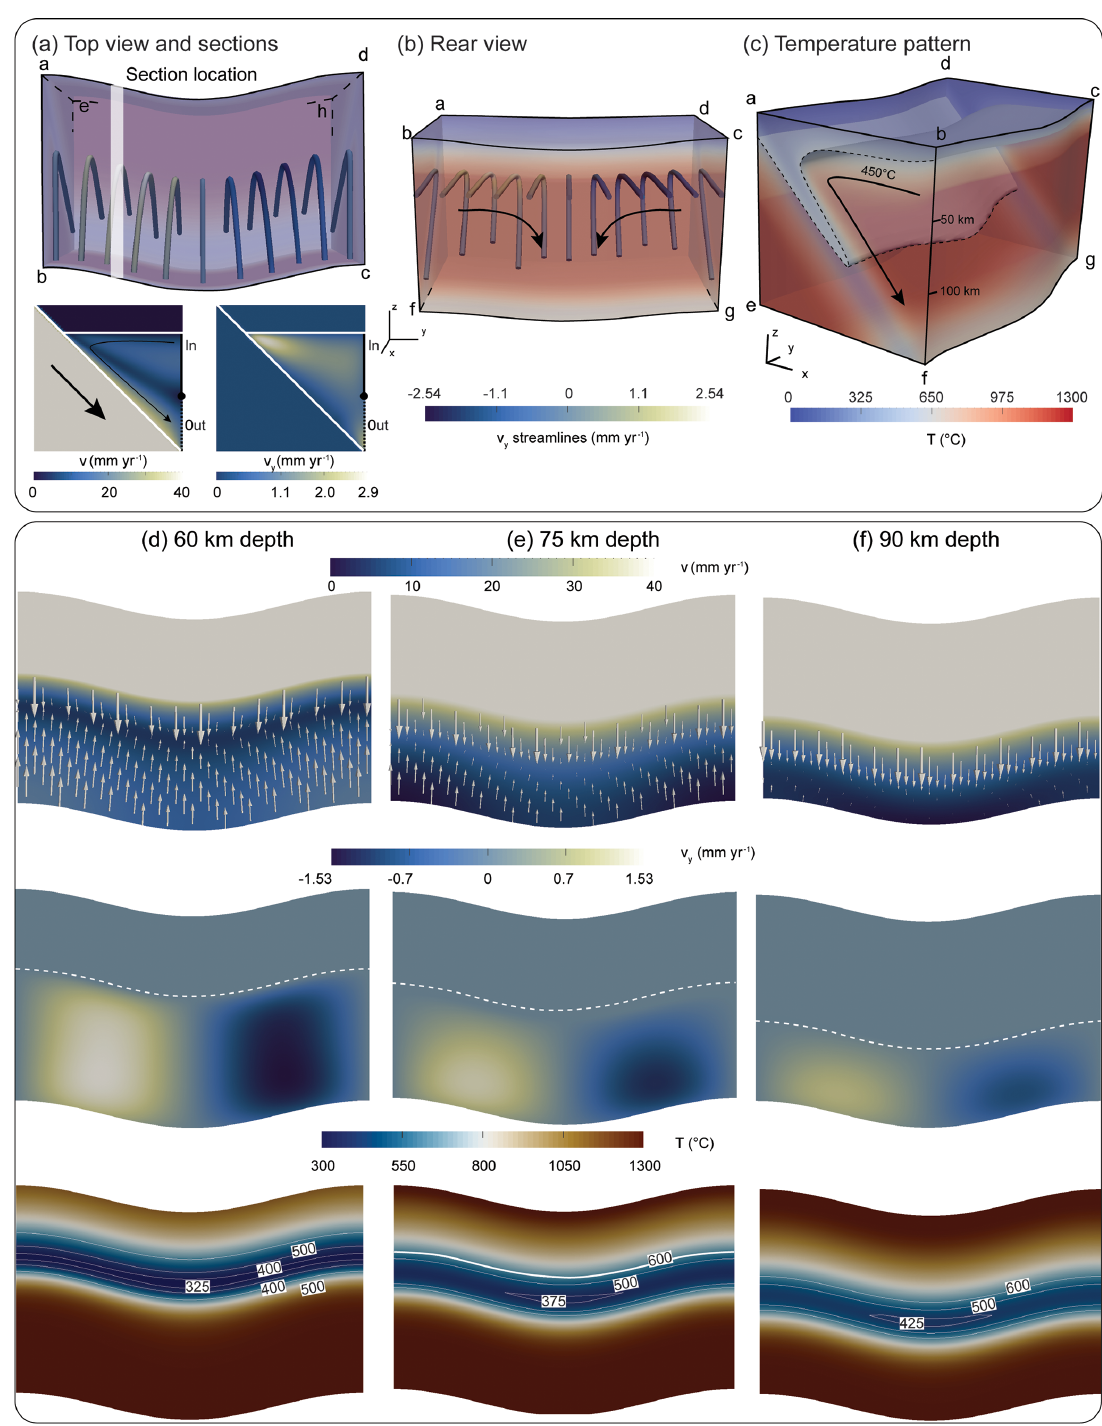
Figure 3. Results of the model SIN20_1. (a) Top view with streamlines showing the trench-parallel mantle flow and sections v and v y at y = 64km; (b) rear view of the domain with emphasis on the trench-parallel flow represented as streamlines; (c) temperature pattern in the model and deflection of the 450 ◦ C isotherm; (d) v , v y and T at 60km of depth; (e, f) same as (d) at 75 and 90km of